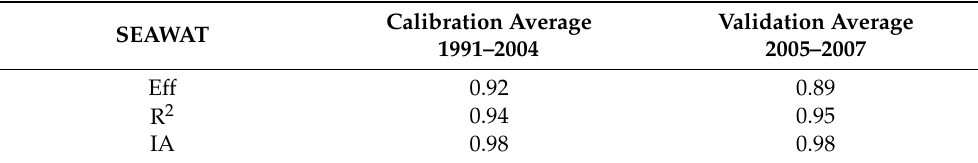
Table 11. Statistical measures of the model’s efficiency for the calibration and validation